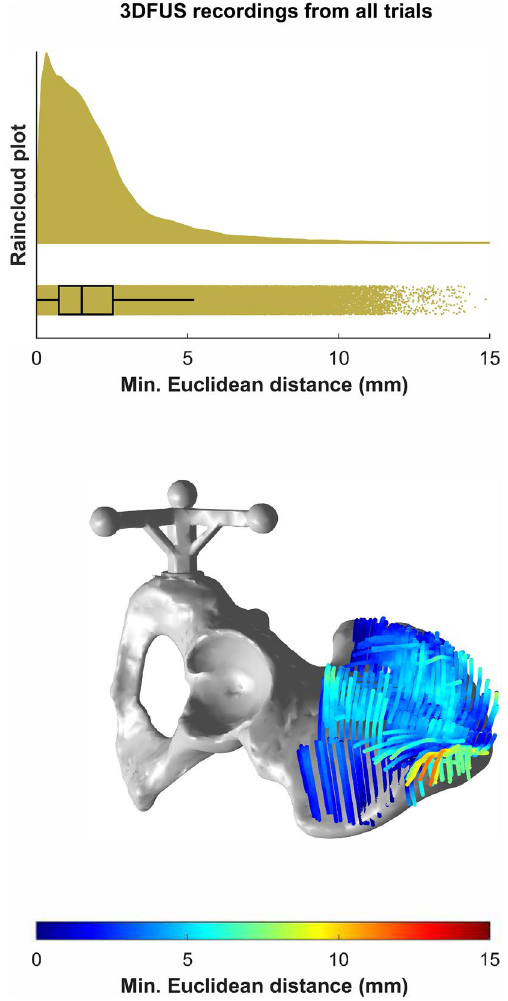
Figure 4. The upper plot shows a rain cloud plot of the minimum Euclidean distances between all 27 3DFUS bone segmentation trials and the laser scan of the measurement phantom (ground truth). Rain cloud plots combine an illustration of data distribution (probability density function), jittered raw data, and a boxplot (with the median) 37 . The lower plot shows a heatmap of the Euclidean distances between the measurement phantom and one single 3DFUS bone segmentation trial. Red colors show greater differences and blue colors smaller ones. The attached cluster of three markers served as a common reference system between the laser scan and the 3DFUS